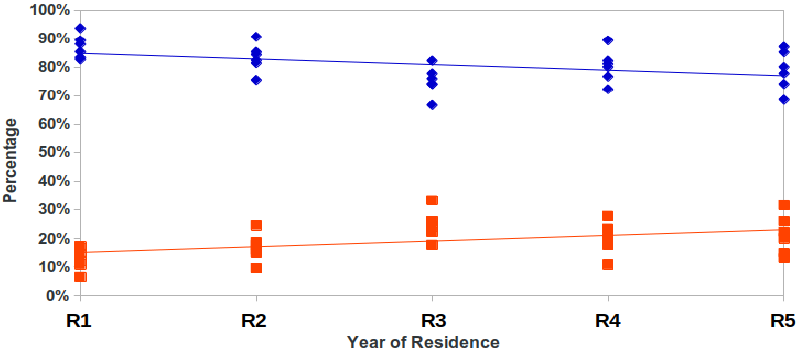
Figure 4. Trendline of positive (blue) and negative (red) answers in medical residents (R, resident).